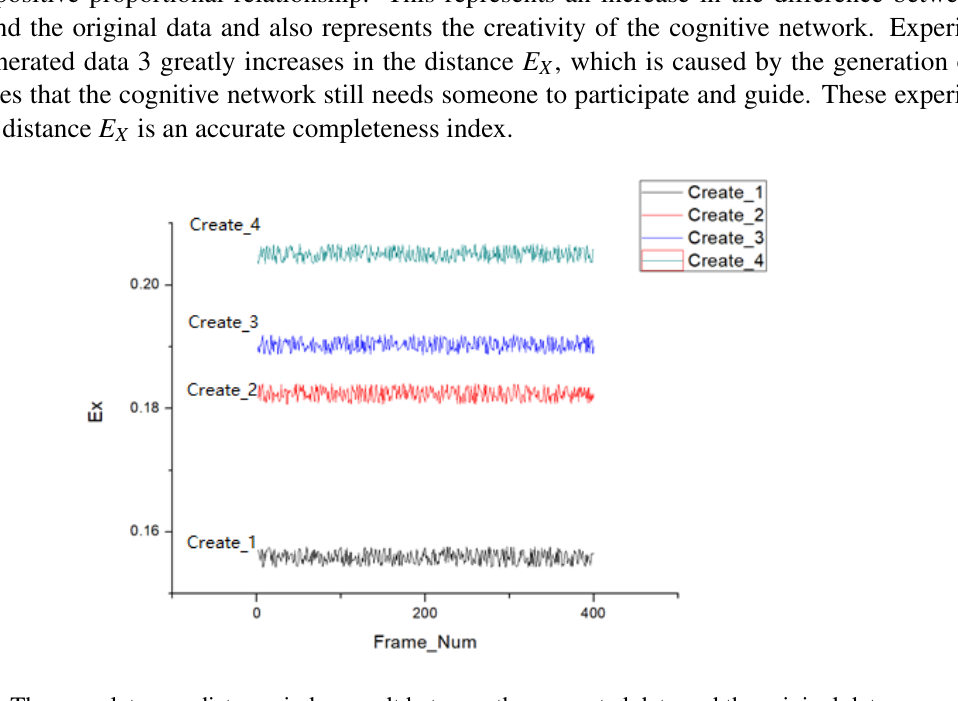
Table of experimental results 7. Figure of experimental results 5.1 The observation distance E X between the